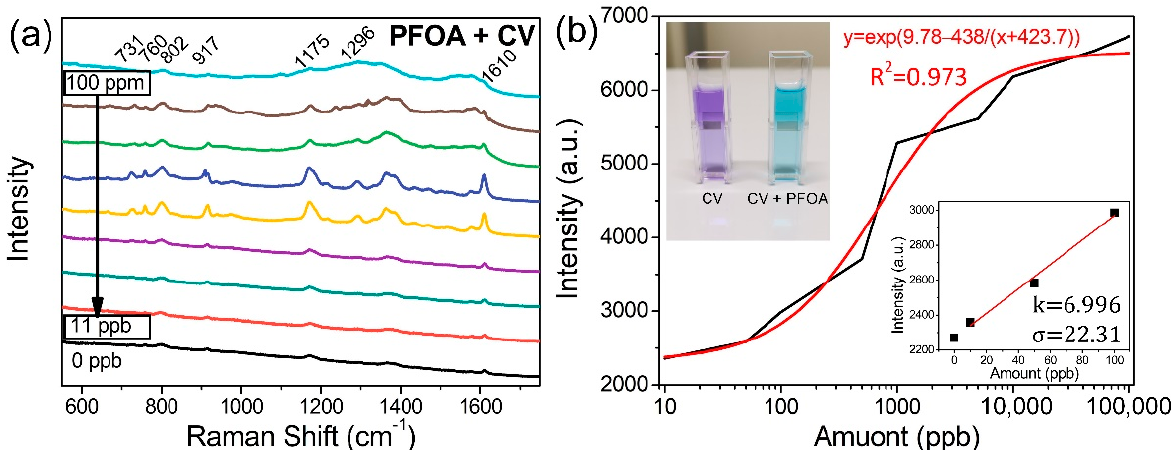
Figure 9. SERS analysis of PFOA using plasmonic hollow nanocluster array. ( a ) SERS spectra of 10 − 7 M CV mixed with different concentrations of PFOA, measured using the plasmonic superstructure array with a period of 500 nm. ( b ) The calibration curve for the sensing of PFOA for the Raman peak at 1175 cm − 1 (inset: photograph of CV solution ( left ) and CV mixed with PFOA solution at a concentration of 100 ppm ( right )). The Raman excitation wavelength was 633 nm. Table 1. Performance of each method for the detection of trace PFOA.